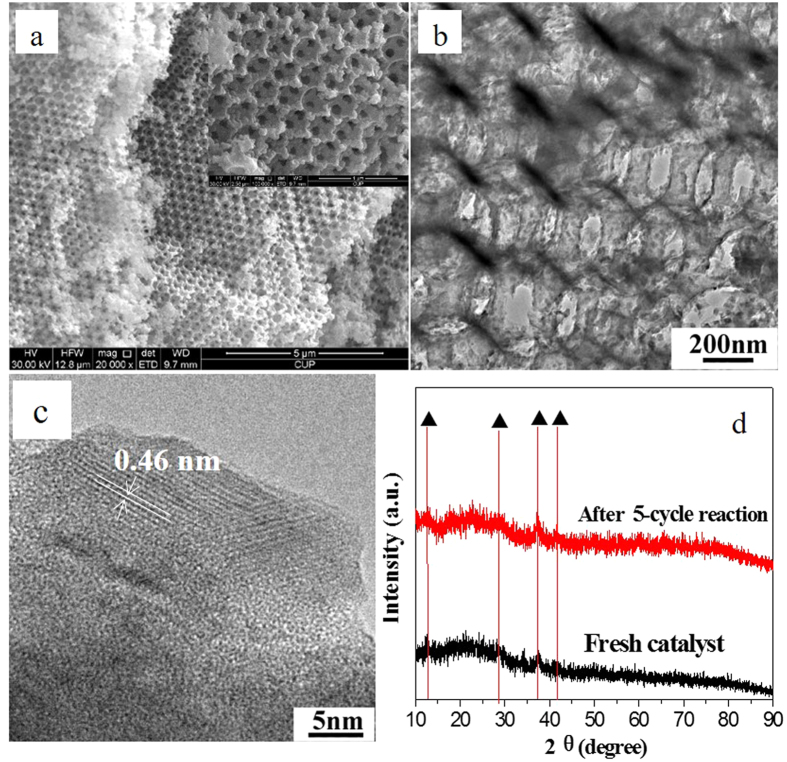
SEM (a), TEM images (b,c), and XRD (d), of 3DOM K-OMS-2/SiO2-50 catalyst after 5-cycle reaction.